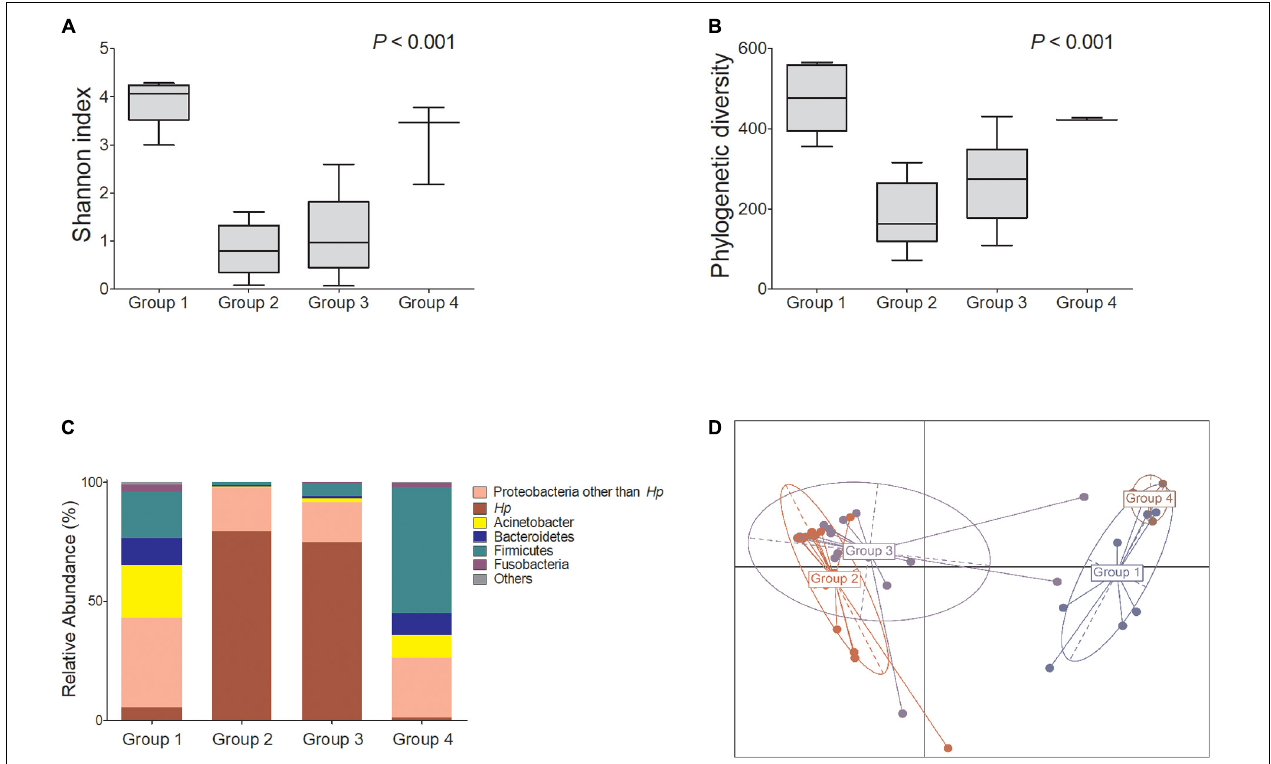
FIGURE 1 | Microbiota composition at gastric corpus mucosae according to Helicobacter pylori infection and the presence of atrophy/metaplasia. H. pylori infection decreased the microbial diversity at corpus ( A , B groups 2 and 3). Compared with group 1 ( H. pylori -uninfected individuals), H. pylori predominates in the gastric corpus microbiota in groups 2 and 3 ( H. pylori -infected subjects), and relative abundance of Firmicutes was increased in group 4 ( C H. pylori -negative subjects with atrophy/metaplasia). (D) Principal coordinates analysis showed that the study subjects can be clearly discriminated by H. pylori infection status (groups 1 and 4 vs. groups 2 and 3) but not by the presence or absence of atrophy/metaplasia. The four groups were significantly different (Bray–Curtis, unweighted, PERMANOVA p < 0.001). Group 1: H. pylori -uninfected subjects without evidence of atrophic gastritis and intestinal metaplasia by histology, pepsinogen I/II ratio ≥ 4.0, and no history of H. pylori eradication ( n = 8); group 2: H. pylori -infected patients without mucosal atrophy and metaplasia by histology with pepsinogen I/II ratio > 4.0 ( n = 15); group 3: H. pylori -infected patients with atrophic gastritis and/or intestinal metaplasia by histology and pepsinogen I/II ratio < 2.5 ( n = 17); group 4: the patients with atrophy/metaplasia, no evidence of active H. pylori infection, negative for anti- H. pylori IgG antibody test, and no previous history of H. pylori eradication ( n = 3). Hp , Helicobacter pylori